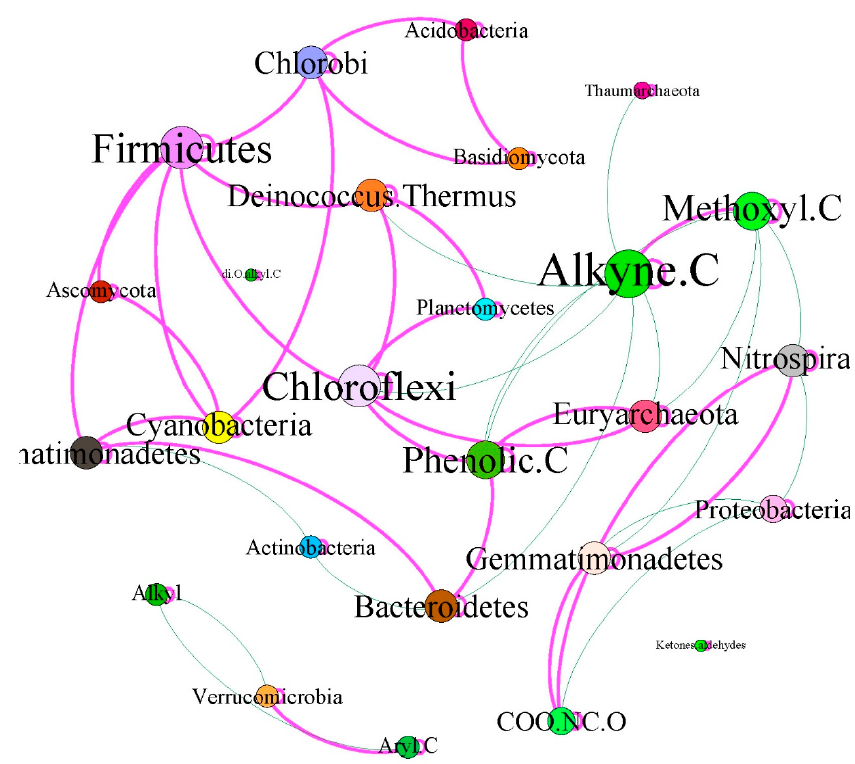
Figure 13. Network analysis demonstrating the relationships between microbial community composition and SOC chemical functional groups. Red lines represent strong positive linear ( r > 0.8), and green lines represent strong negative linear ( r < − 0.8) relationships.